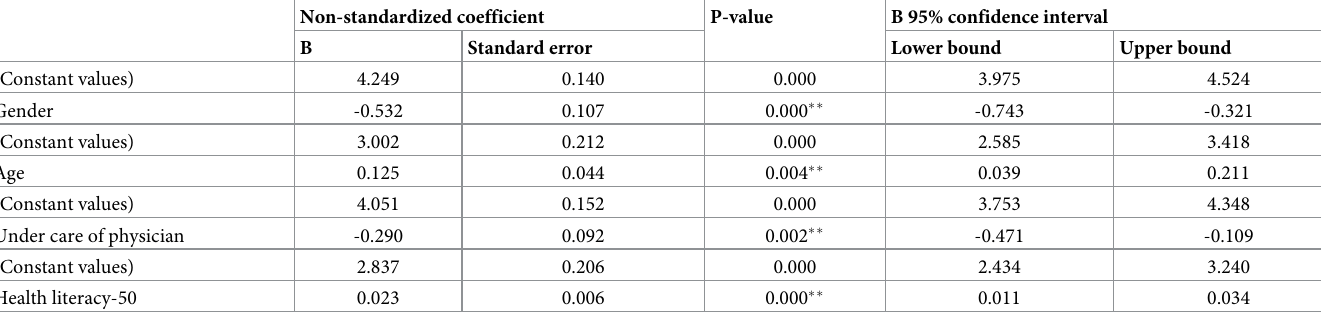
Table 7. Univariate linear regression analysis of willingness to undergo vaccination, predictive